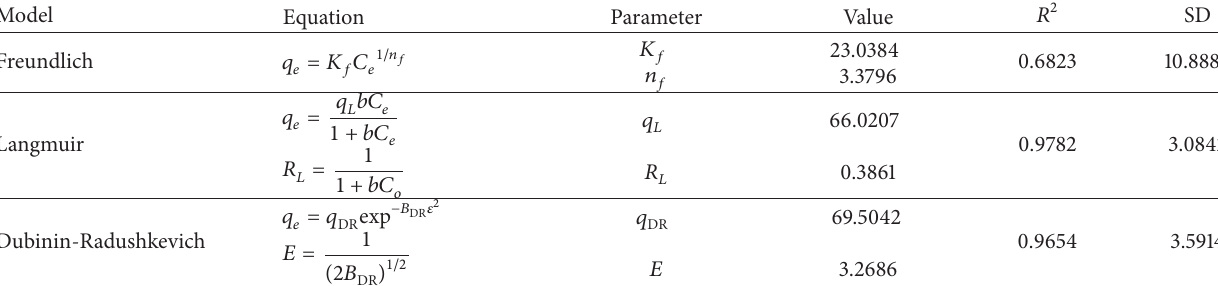
Table 5: Data of isotherm models for dye biosorption.